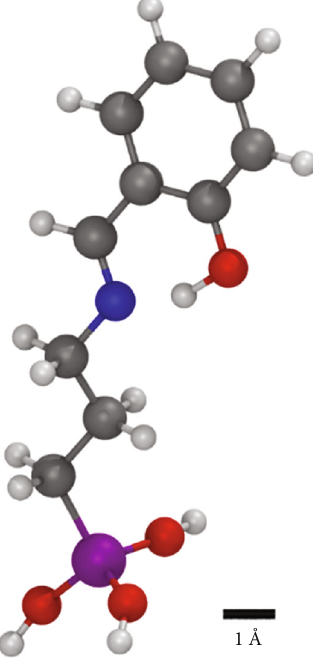
Figure 7: Representation of the optimized structure of the hydrolyzed HSPTMS